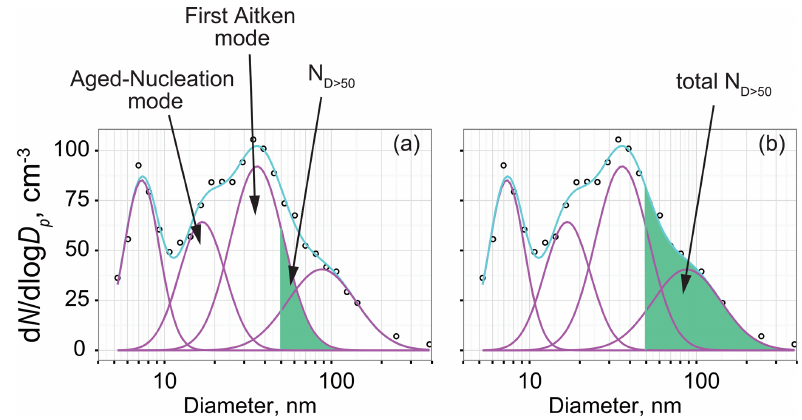
Figure 9. Schematic figure showing procedures used for R CCN estimation. Circles, pink lines, and cyan lines, respectively, show the data observed using SMPS, the number concentrations in each mode approximated by lognormal fitting, and total concentrations of each mode. Number concentrations of aerosols with a size of D p > 50nm in aged-nucleation mode and first Aitken mode ( N D> 50 ) are given as shown for (a) . Similarly, the total number concentrations of aerosols with a size of D p > 50nm (total- N D> 50 ) are given as shown for (b) .